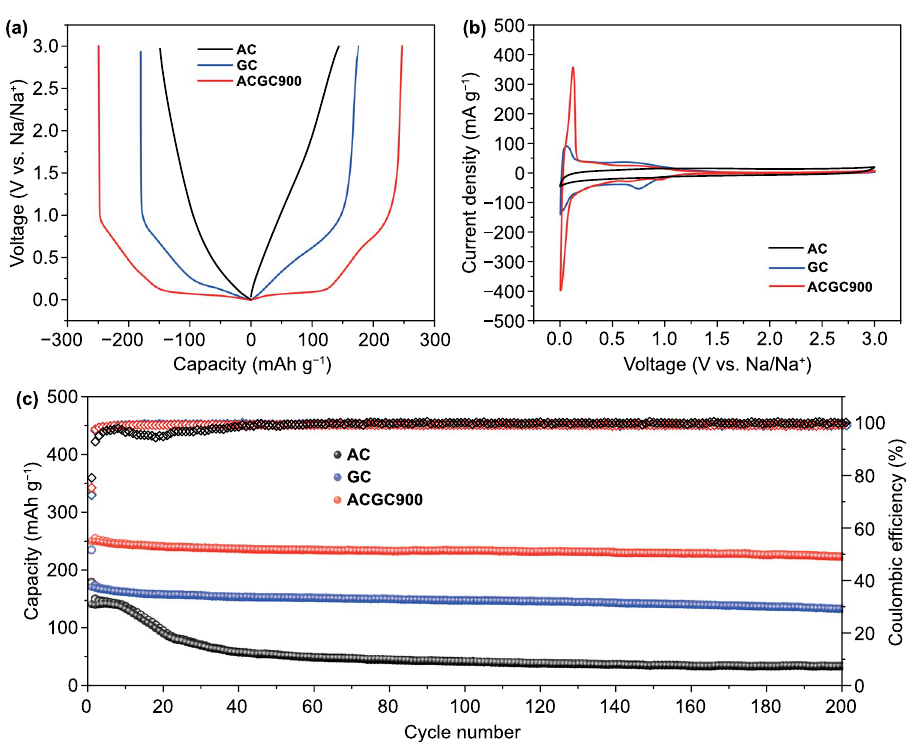
Fig. 2 Electrochemical performance of the AC, GC and ACGC900 electrode in SIBs: a Galvanostatic discharge/charge curves at 50 mA g −1 . b CVs in a voltage range of 0.001–3.0 V vs Na/Na + under 0.1 mV s −1 . c Cycling performance at 50 mA g